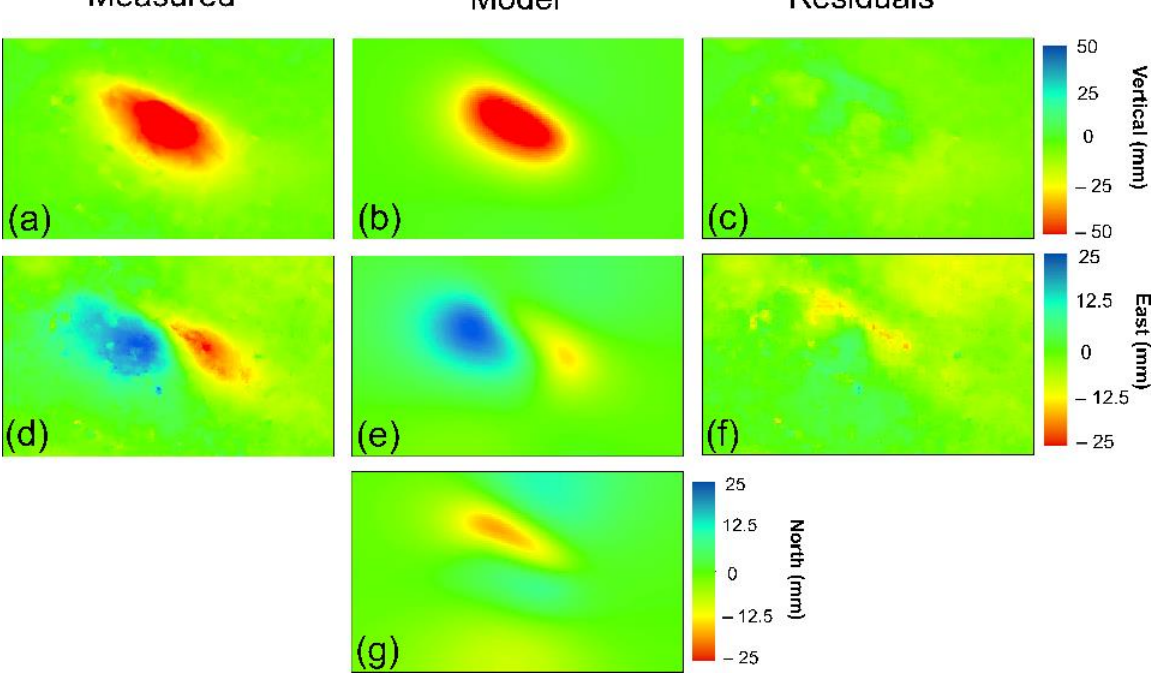
Figure 3. The decomposed deformation (measured, modeled and residual) field. ( a , d ) The vertical and east components, respectively, obtained from the decomposition of the single ascending and descending interferograms. ( b , e , g ) The modeled vertical, east and north components. ( c , f ) The residuals between observed and modelled data.